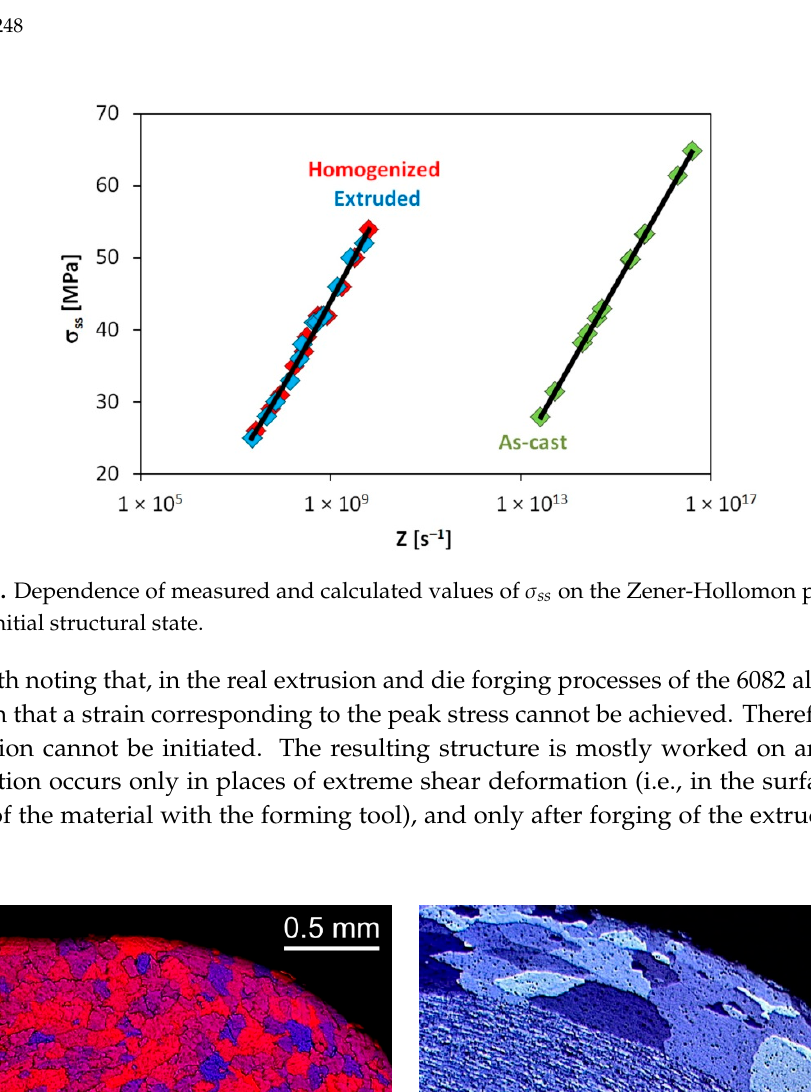
Figure 11. Dependence of measured and calculated values of σ p on the Zener-Hollomon parameter and the initial structural state.